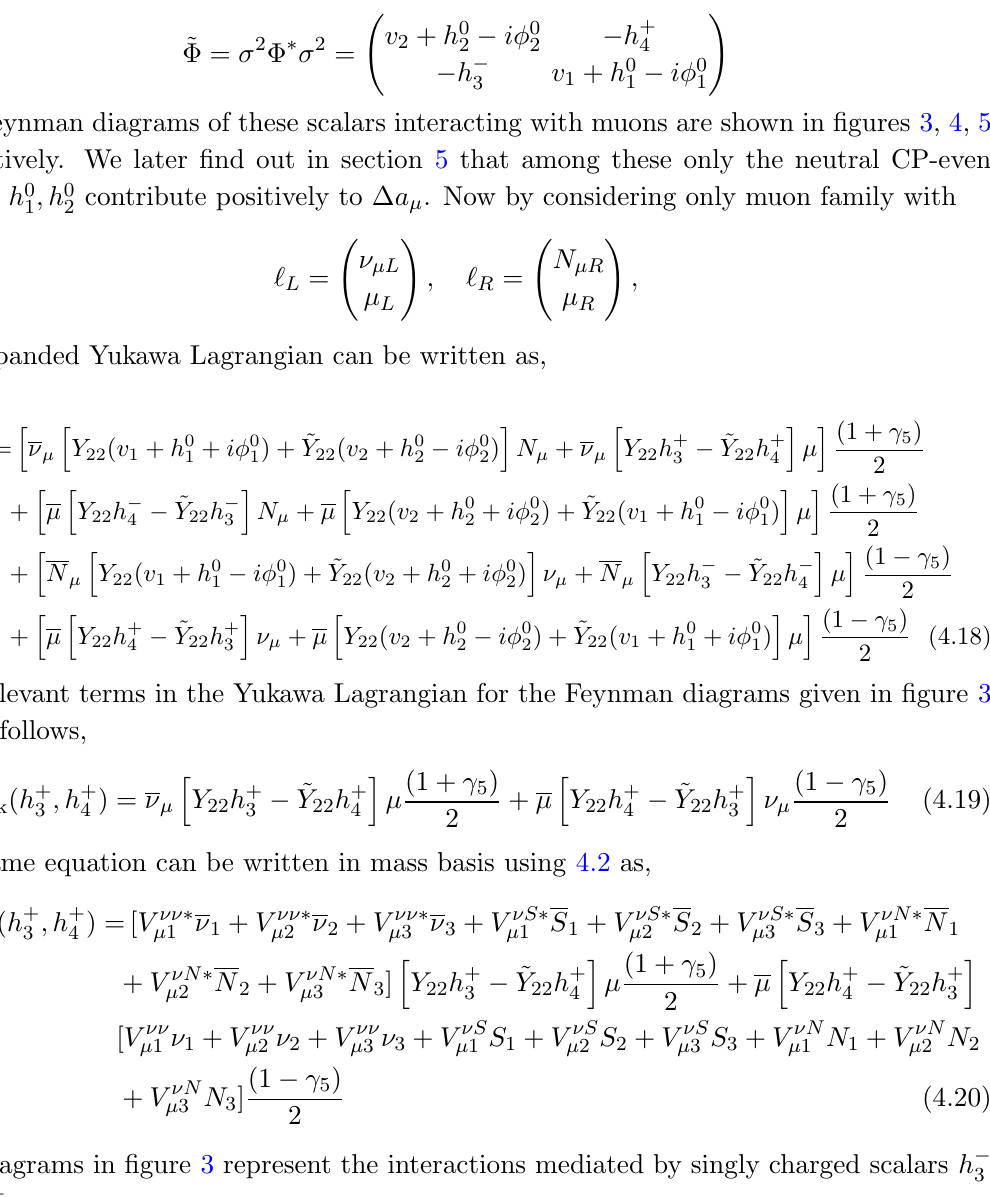
mediation; (cid:1) a 3